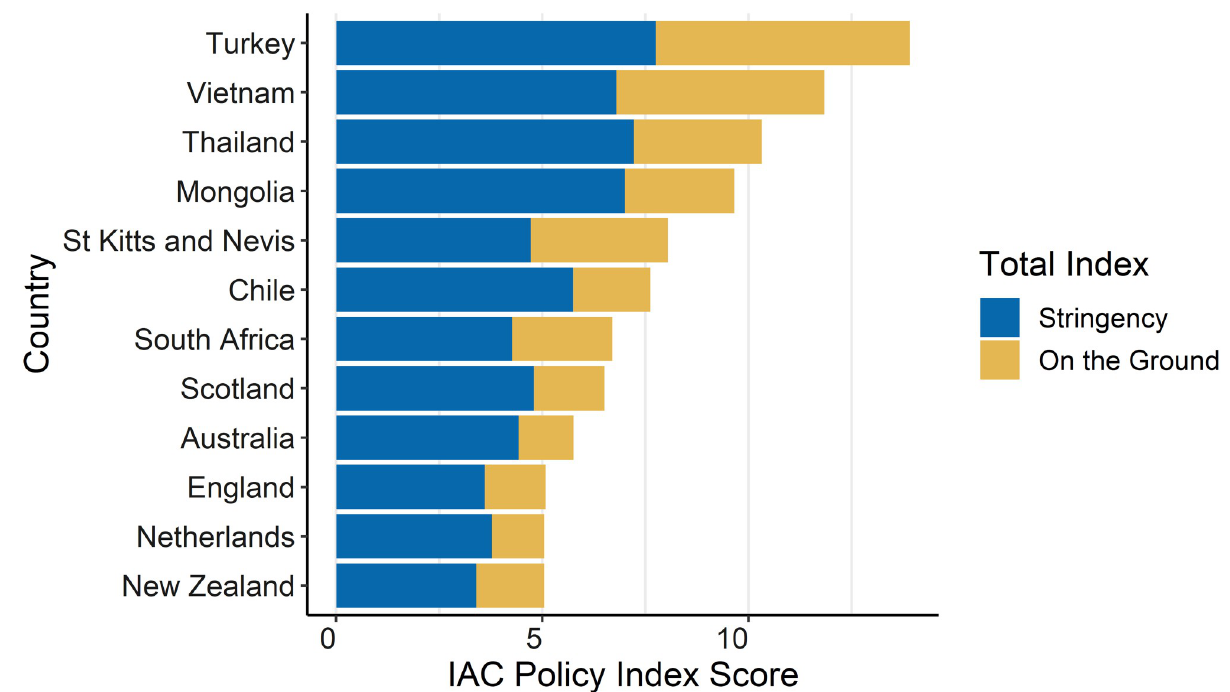
Fig 3. The contribution made by stringency and on-the-ground impact for each